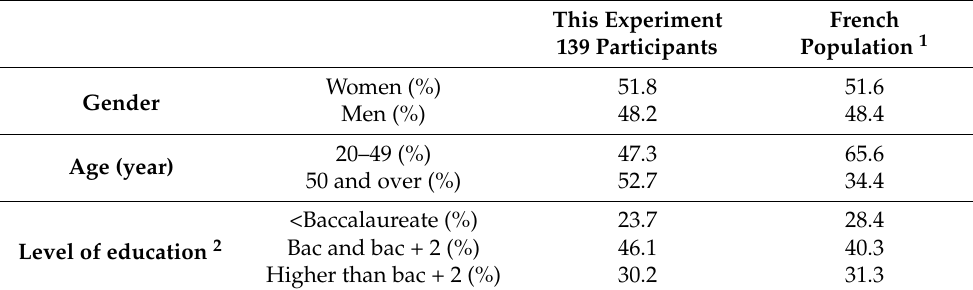
Table 1. Sociodemographic characteristics of